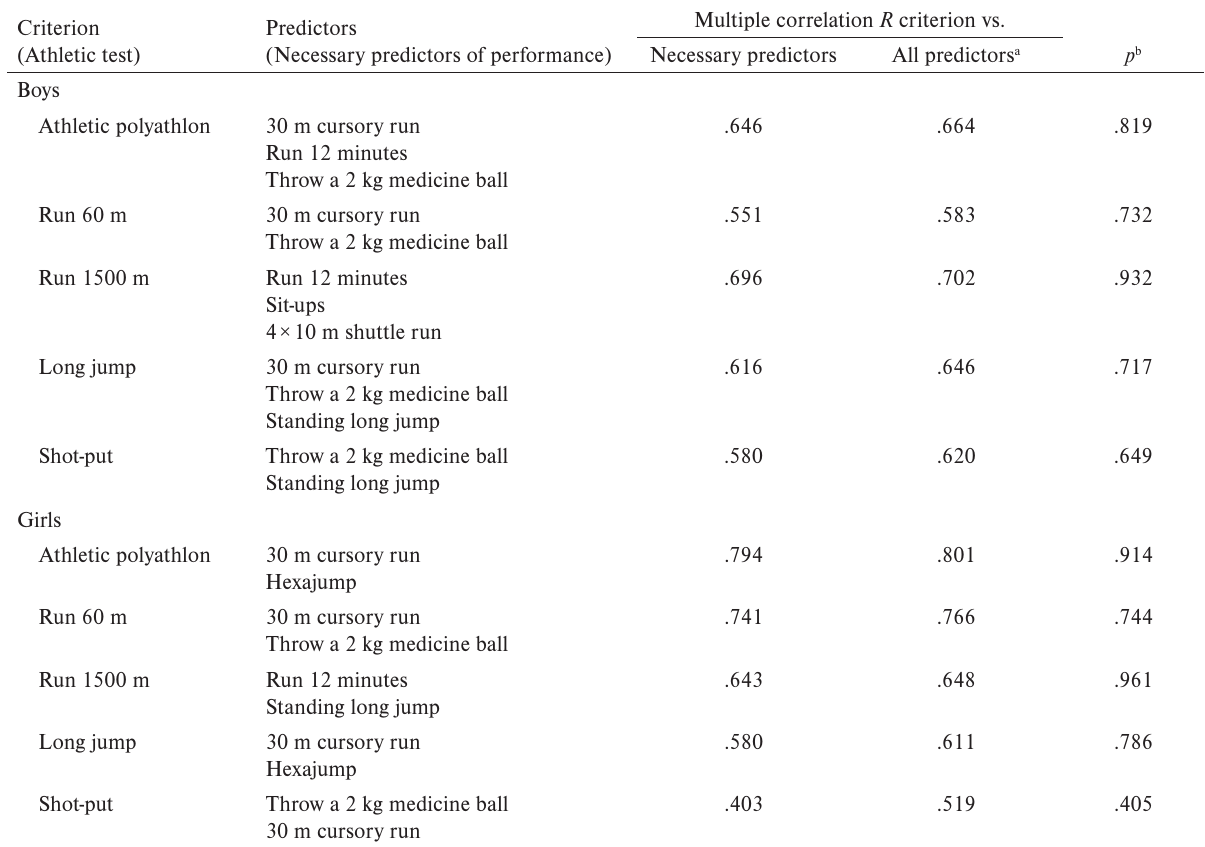
Table 6 The review of key predictors of given